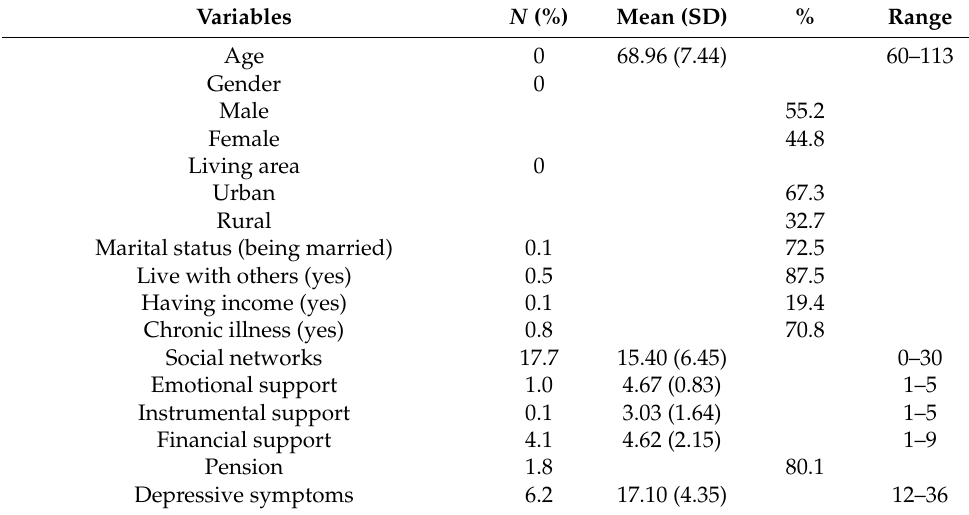
Table 1. Sample Characteristics ( N = 6687).